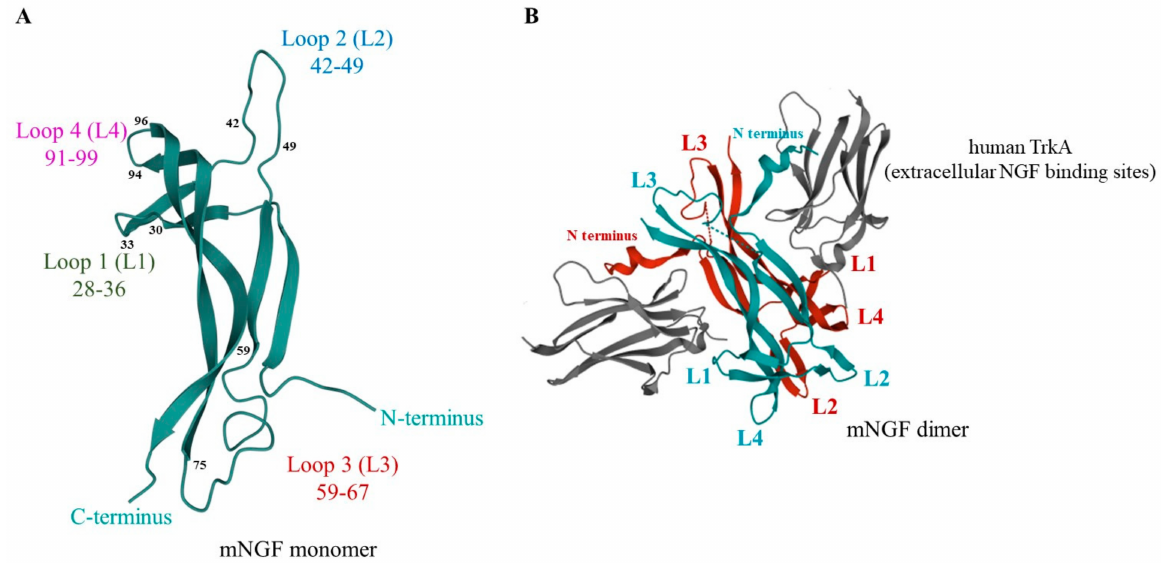
Figure 1. Structure of ( A ) mNGF (PDB ID: 1 BET) monomer [60]. The exposed β -turn loops L1 (residues 28-36), L2 (residues 42-49), L3 (residues 59-67) and L4 (residues 91-99) were used to design peptides. ( B ) The mNGF dimer (red and blue)-TrkA extracellular domain (black) binding sites (PDB ID: 2IFG [61])